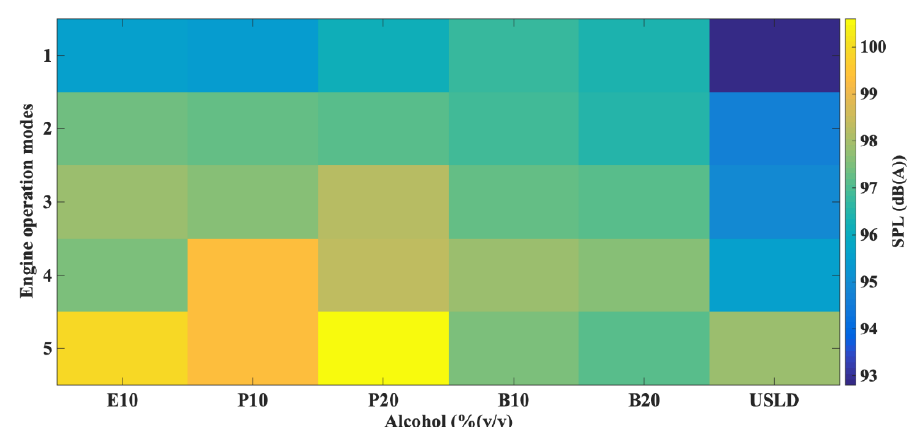
Figure 7. Sound pressure level (SPL) for alcohol/diesel fuel blends; 10% ( v / v ) ethanol/diesel fuel (E10), 10% ( v / v ) propanol/diesel fuel (P10), 20% ( v / v ) propanol/diesel fuel (P20), 10% ( v / v ) butanol/diesel fuel (B10), 20% ( v / v ) butanol/diesel fuel (B20) and 100% ultra-low -sulfur diesel fuel (USLD).